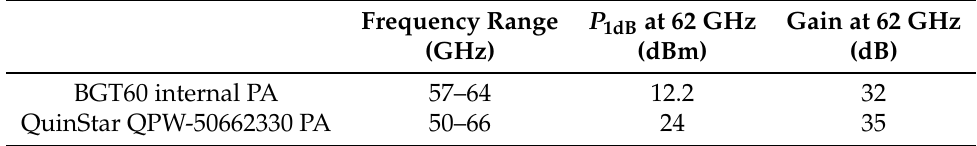
Table 5. Parameters of power amplifiers at 62